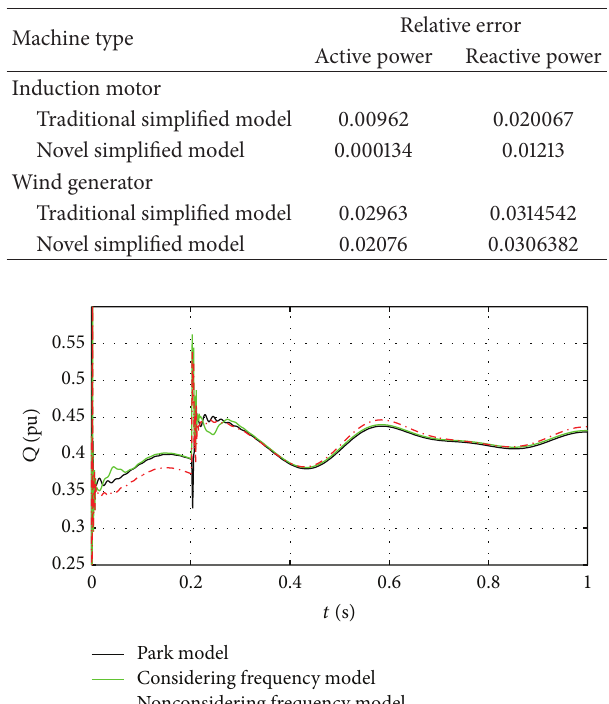
Figure 4: System frequency.